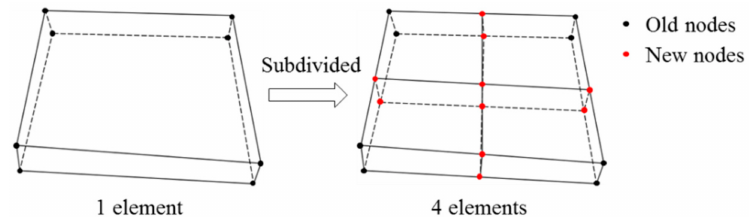
Figure 2. In-plane subdivision of the solid-shell element.